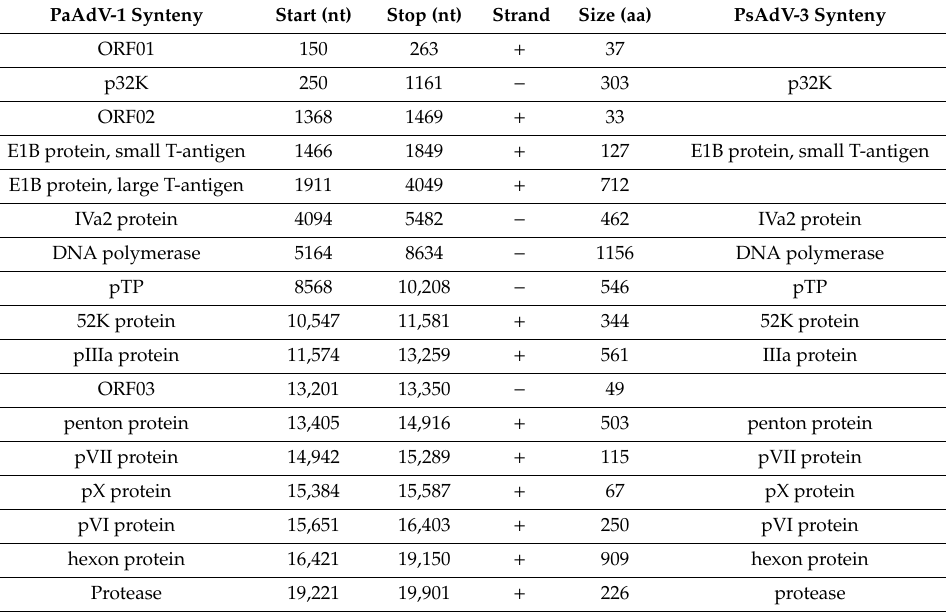
Table 1. Predicted protein-coding genes of